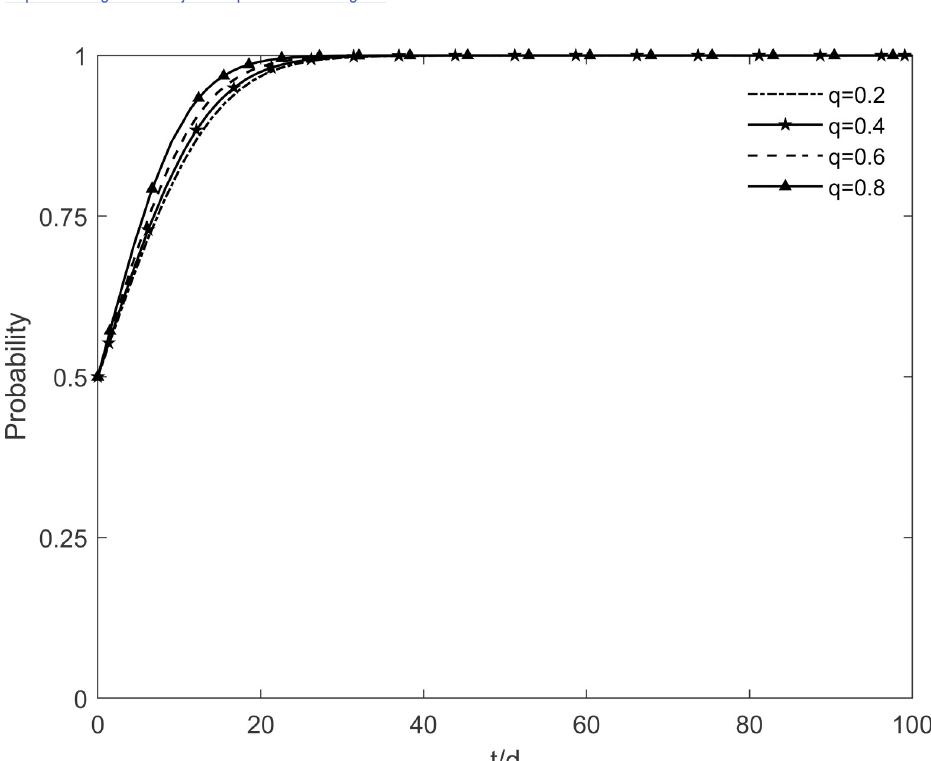
Fig 11. The impact of q on residents’ strategic choices.